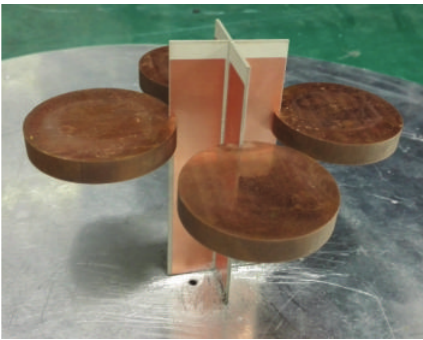
Figure 8: Photo of the cross-dipole.